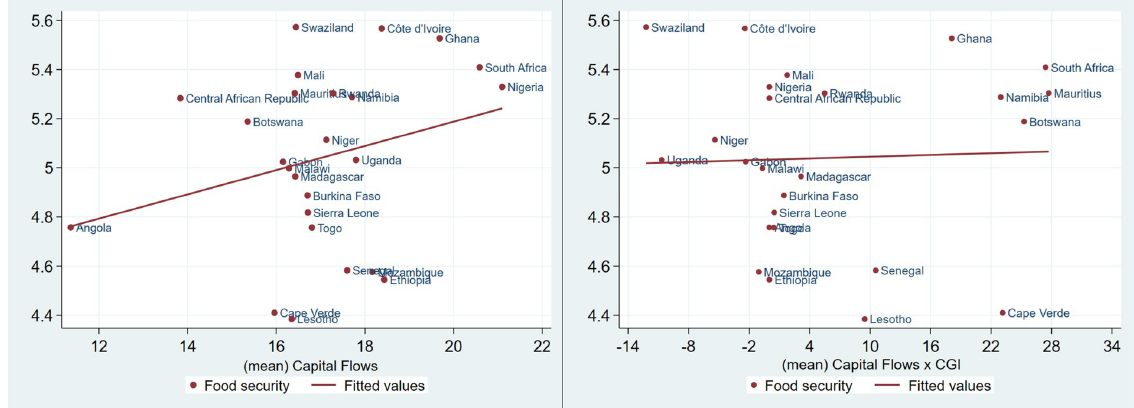
Fig 1. Food security, capital flows and the interaction of governance and capital flows in SSA (1996 to 2018). Source: Authors’ analysis from FAOSTAT, WGI and WDI.